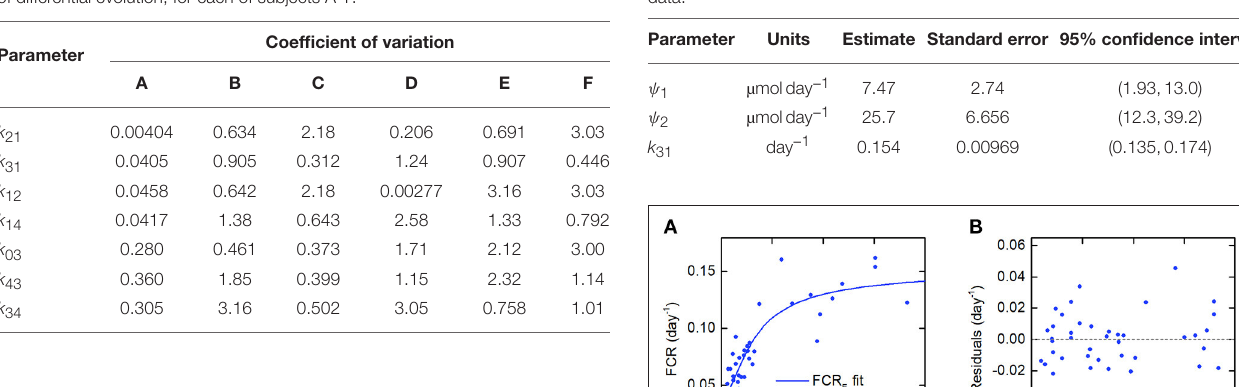
TABLE 5 | Parameter estimates from fitting FCR E expression to FCR T vs. x 1,E data.